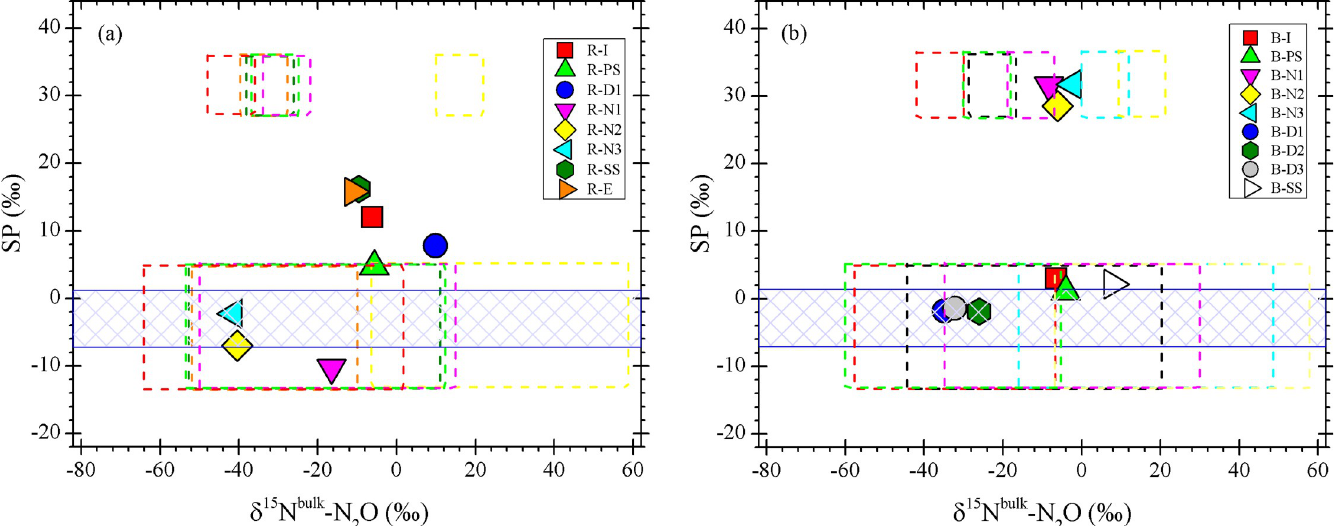
Fig 4. Correlations between SP and δ 15 N bulk of dissolved N 2 O in wastewater from Ruelzheim (a) and Bellheim (b), respectively. Expected ranges for N 2 O produced via NH 2 OH oxidation and NO 2- reduction calculated according to Toyoda et at. [2005] with the δ 15 N of NH 4+ and the reported isotope effects for each process and corresponding SP are marked by boxes in different colors. We applied the enrichment factors during NH 4+ oxidation to N 2 O ( ε 15 N NH4+ ! N2O ) of –60 to –48‰ and NO 2- reduction from NH 4+ to N 2 O ( ε ( 15 N) NH4+ ! NO2- ! N2O ) of –76 to –11‰. For N 2 O produced by NO 2- reduction (denitrification) in samples taken from denitrification basin (blue color), δ 15 N of NO 3- could not be estimated due to lack of substrate isotope ratio measurement. The SP of N 2 O produced by NH 2 OH oxidation was assigned as +27.2‰- +35.6‰, whereas those by NO 2- reduction during nitrifier-denitrification were -13.6‰- +5.0‰.